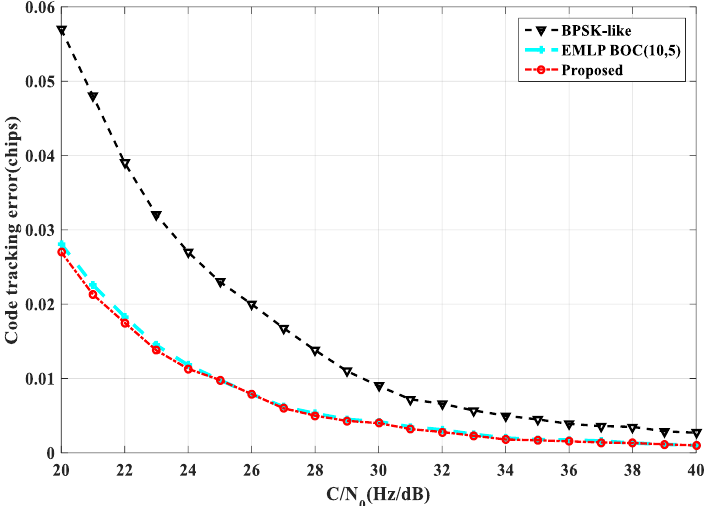
Figure 24. Code tracking error standard deviation of BOC (10,5).